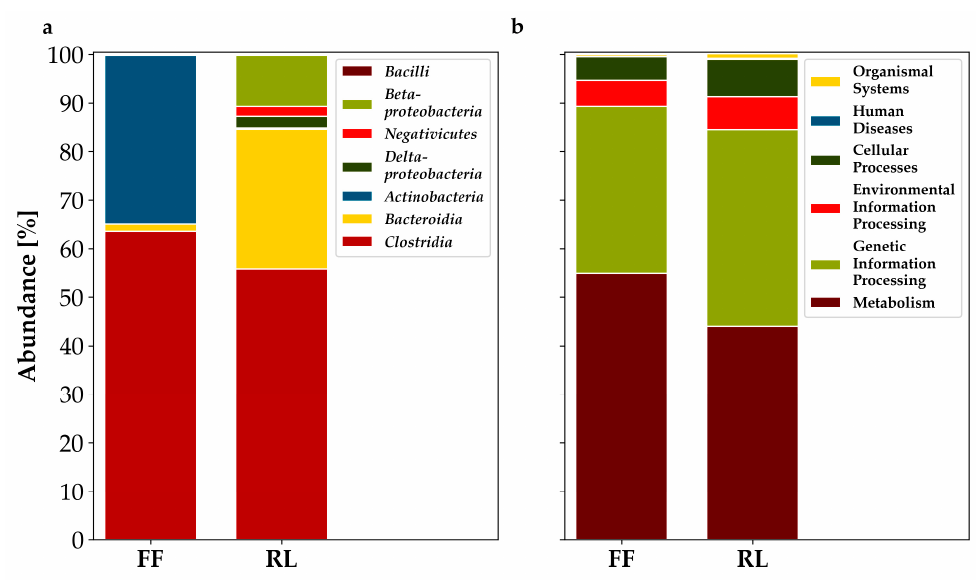
Figure 2. Analysis of proteins significantly different in abundance. ( a ): Proportions of taxonomy of proteins at class level; ( b ): Functional analysis of proteins which were mappable to the KEGG Orthology database and that had a functional annotation assigned. Contains only protein identifications that occurred in at least two of three replicates (normalized NSAFs, significance testing: Fold change ≥ 1.5, t -test, Benjamini–Hochberg-corrected, p < 0.05) and that could be annotated. FF: flash frozen; RL: RNAlater-treated.